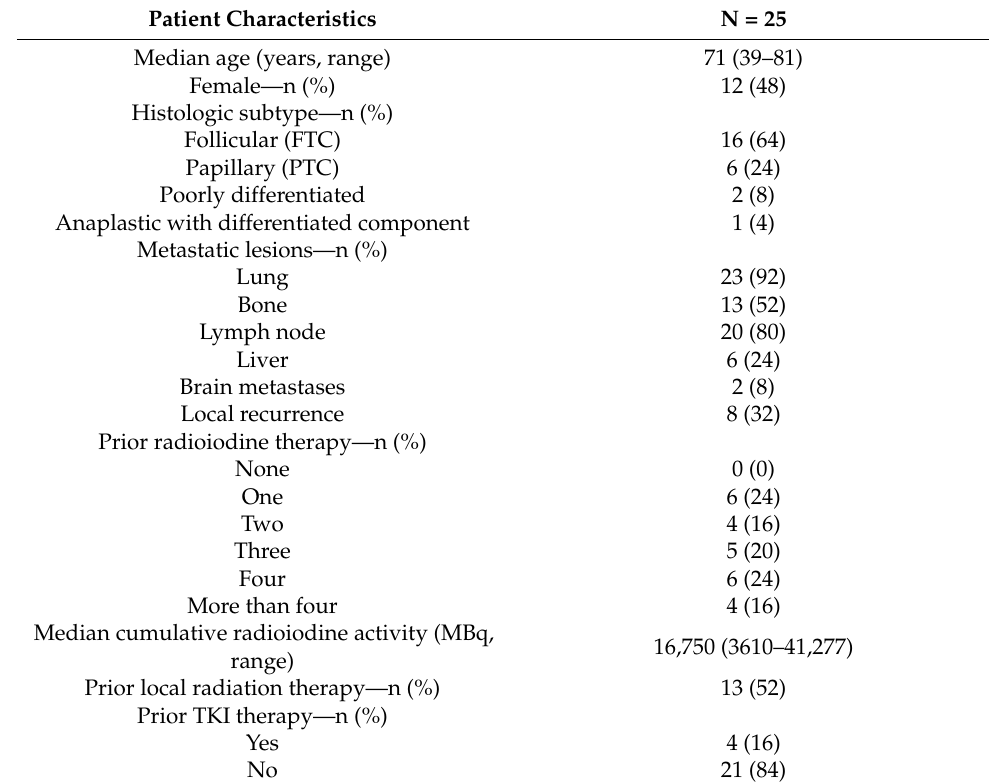
Table 2. Patient